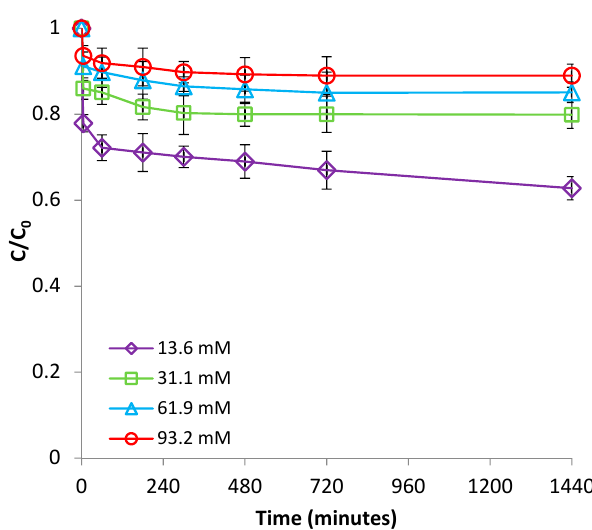
Figure 4. Effect of ionic strength on Fe(II) removal by bentonite.